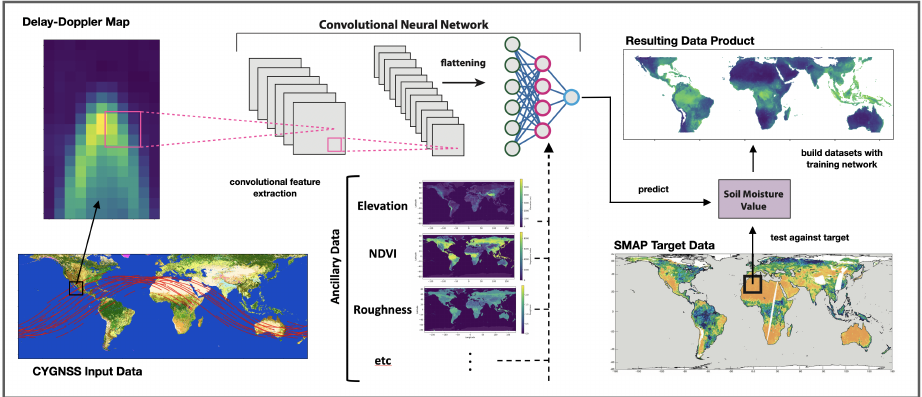
Figure 3. Overview of surface parameter estimation with a convolutional neural network using delay-Doppler maps and ancillary data as inputs, and SMAP soil moisture values as